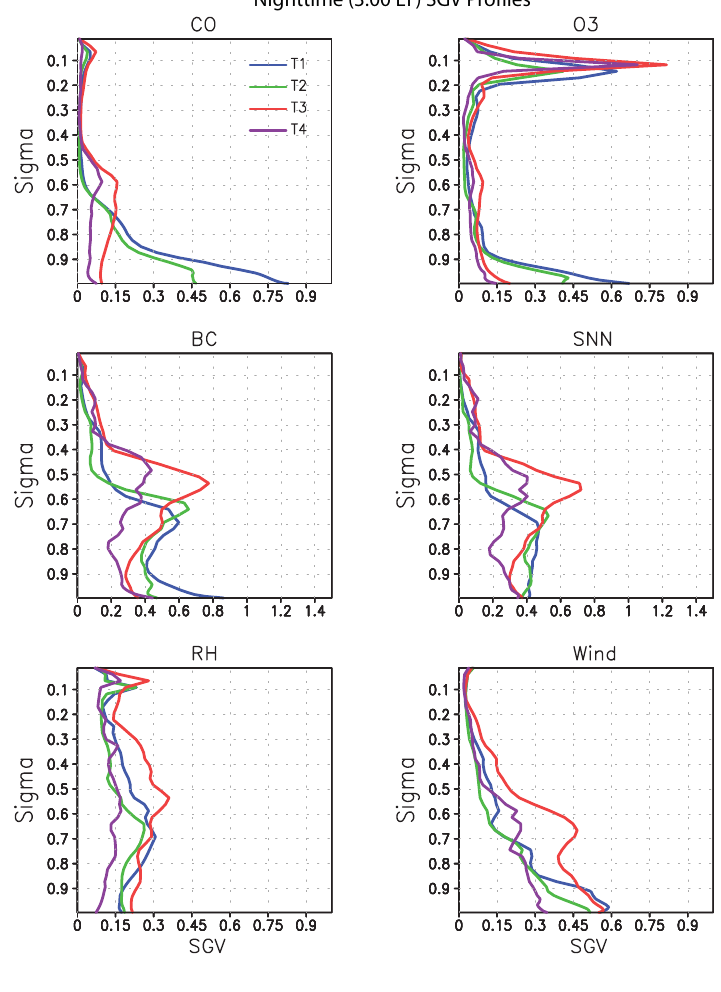
Fig. 12. Same as in Fig. 11 but at